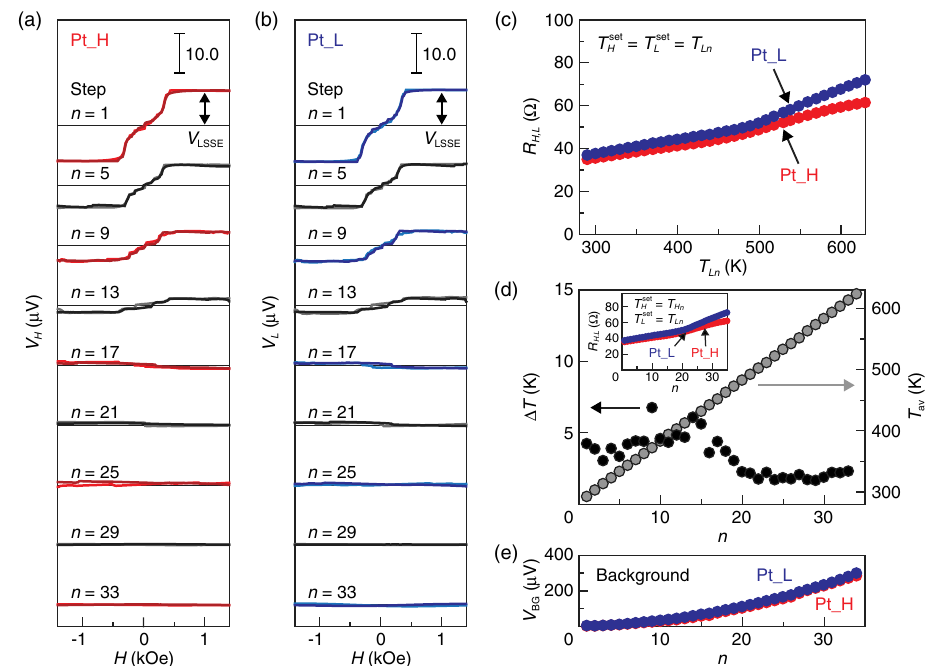
FIG. 2. (a) H dependence of V H for Pt_H in the Pt = YIG = Pt sample for various values of n . (b) H dependence of V L for Pt_L. The LSSE voltage V for Pt_H (Pt_L) is defined as V H ( V L ) at H ¼ 1 kOe. (c) T Ln dependence of R H ( R L ) for Pt_H (Pt_L) in the LSSE isothermal condition: T set H ¼ T set L ¼ T Ln . (d) The average temperature T and temperature difference Δ T of the Pt = YIG = Pt sample av during the LSSE measurements as a function of n . The inset of (d) shows R H ( R L ) for Pt_H (Pt_L) as a function of n under the temperature gradient: T set H ¼ T Hn and T set L ¼ T Ln with T Hn > T Ln . (e) The background voltage V for Pt_H and Pt_L as a function of n BG under the temperature